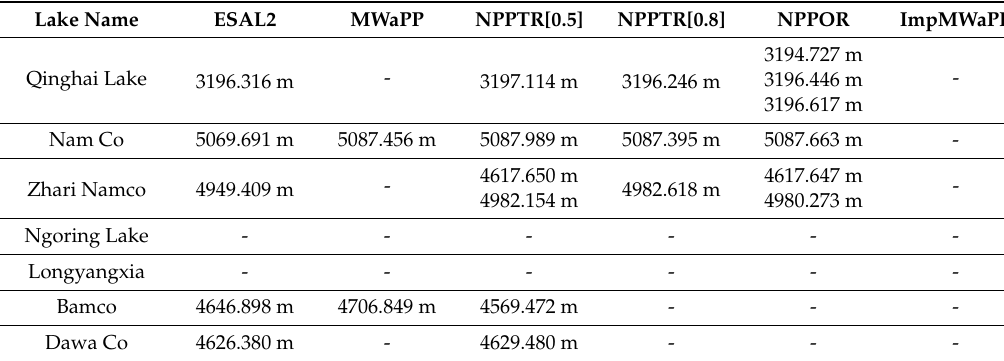
Figure A1. Waveforms at spots 1–12 corresponding to Figure 3a. Table A1. Abnormal track mean